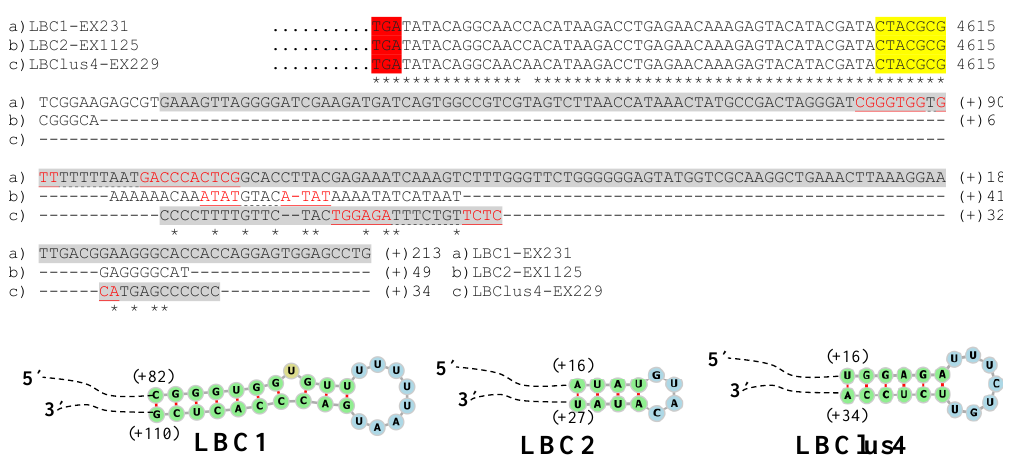
Figure 5. Nucleotide sequence (cDNA) alignment of 3 ′ -extra sequences and proximal canonical sequences of ScV-LBC genomes: ( a ) LBC1-EX231, ( b ) LBC2-EX1125 and ( c ) LBClus4-EX229. Aster- isks (*) indicate identical nucleotides. The CTACGCG-3 ′ ends of canonical sequences are yellow highlighted. The protein synthesis stop codons of Gag-Pol are red-shaded. The 3 ′ -extra sequences identical to rRNA stretches (18S in LBC1-EX231, and 25S in LBClus4-EX229) are grey shaded. Nu- cleotides of palindromic sequences are shown in red. The stem-loops sequences are underlined. The unpaired nucleotides of each loop are dot underlined. The secondary RNA structure of possi- ble 3 ′ stem-loops is shown at the bottom of the sequences.